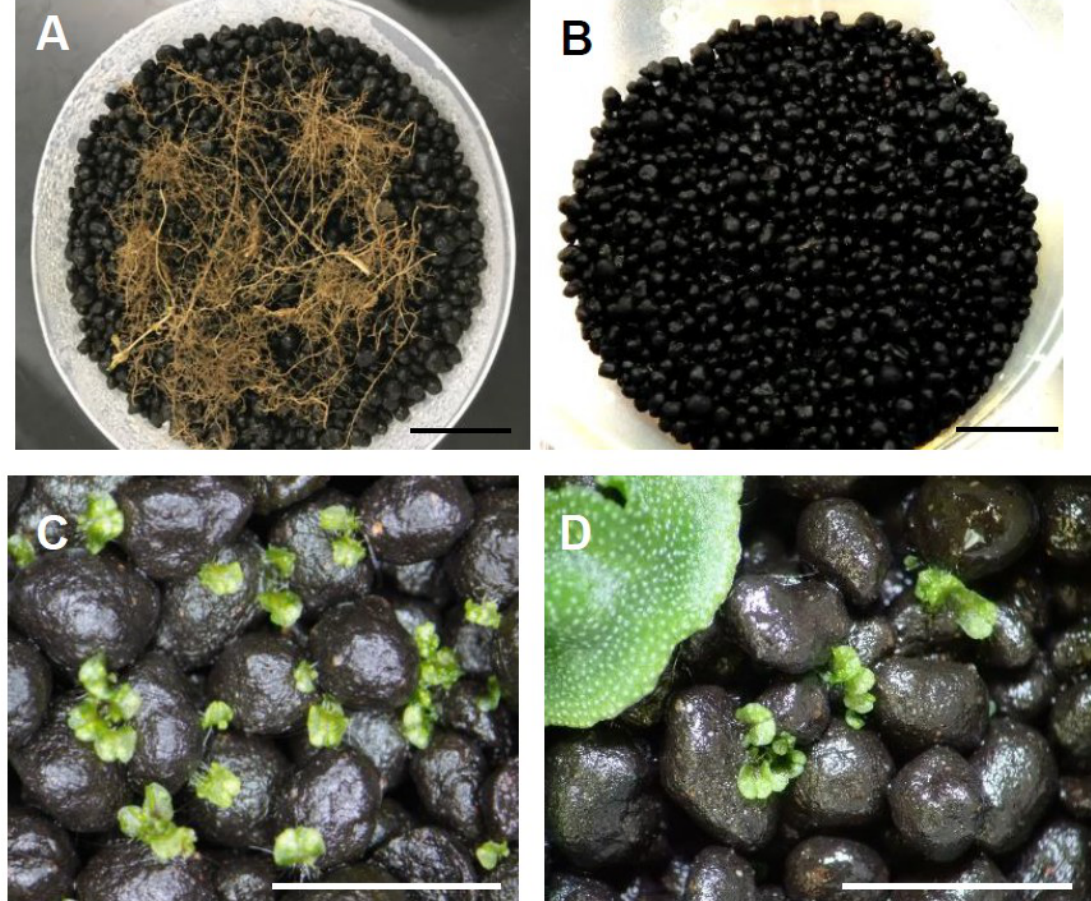
Figure 2. Pot preparation and mycothalli images. ( A ) Roots were deposited on soil. ( B ) Roots were buried within soils at a depth of ~5 mm. ( C ) Gemmae (young thalli) of Marchantia paleacea at 14 days post-sowing (dps) (i.e., first mycothalli). ( D ) M. paleacea gemmae at 14 dps (i.e., second mycothalli) were transplanted around donor mycothalli. Bar = 2 cm ( A and B ); 5 mm ( C and D ).